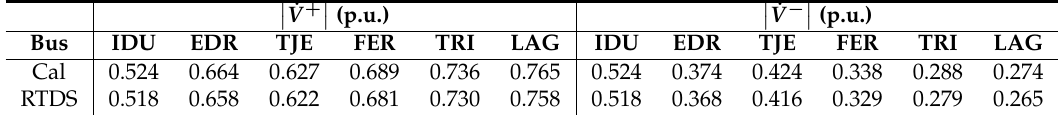
Table 6. Comparison between calculations and simulations (A–B fault).